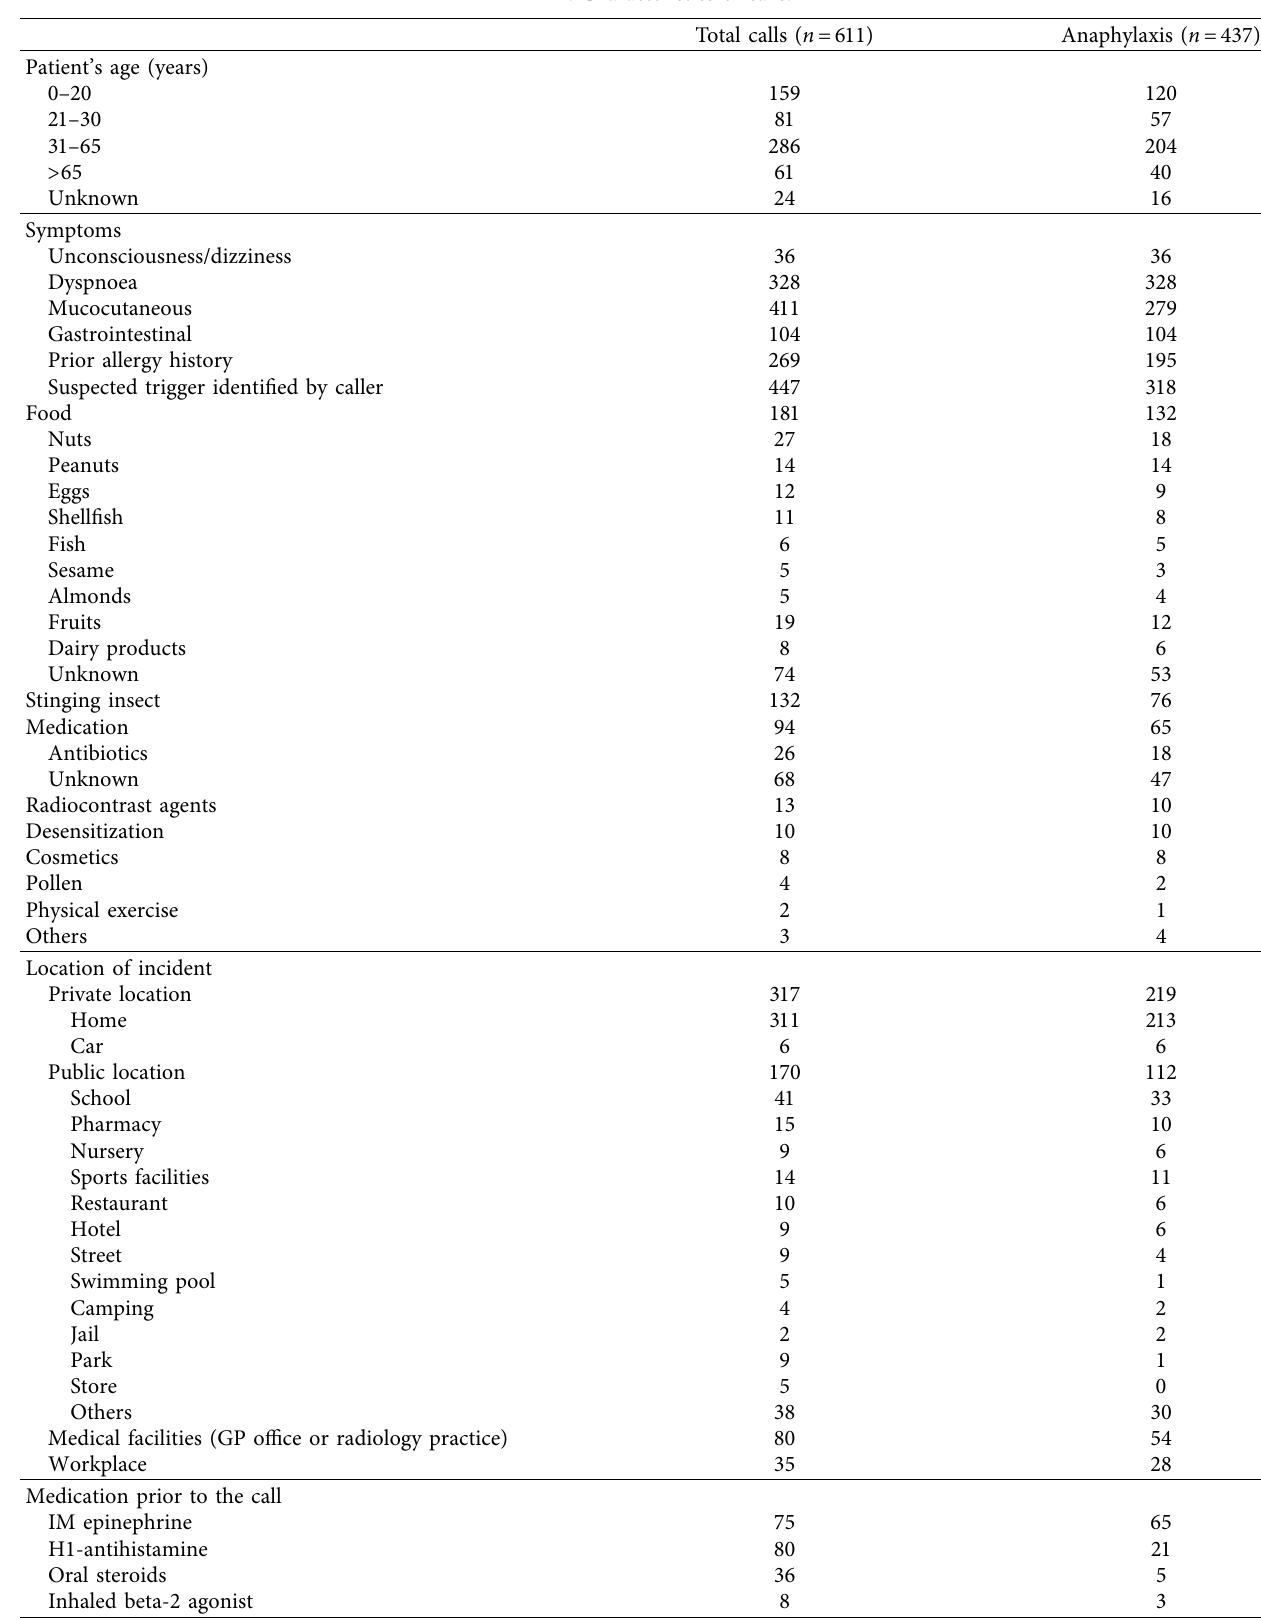
Table 1: Characteristics of